Question: Briefly state, in one sentence, what is plotted here.
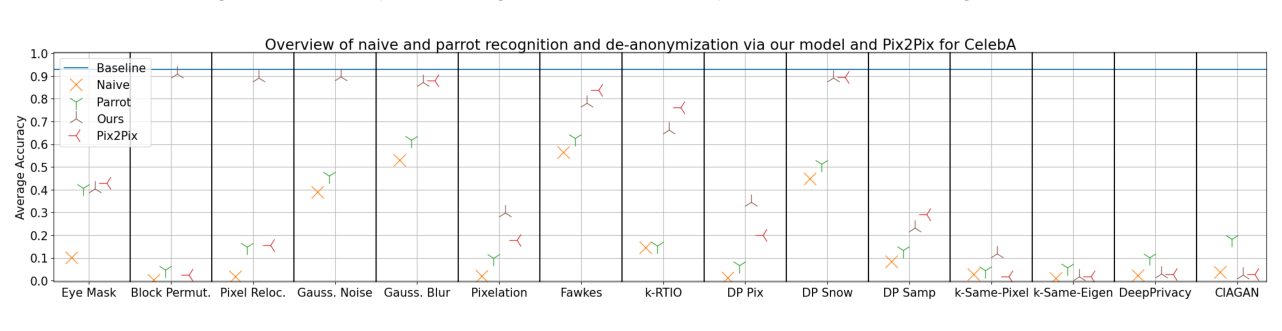
Answer: Average recognition accuracy for every anonymization method for baseline, naive, parrot, de-anonymized via our model, and de-anonymized via Pix2Pix; on 300 identities of CelebA.